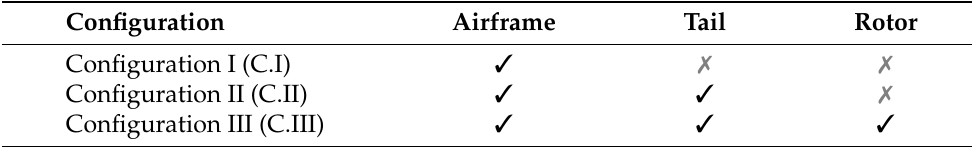
Table 8. Aircraft configurations tested for roll maneuver coupled